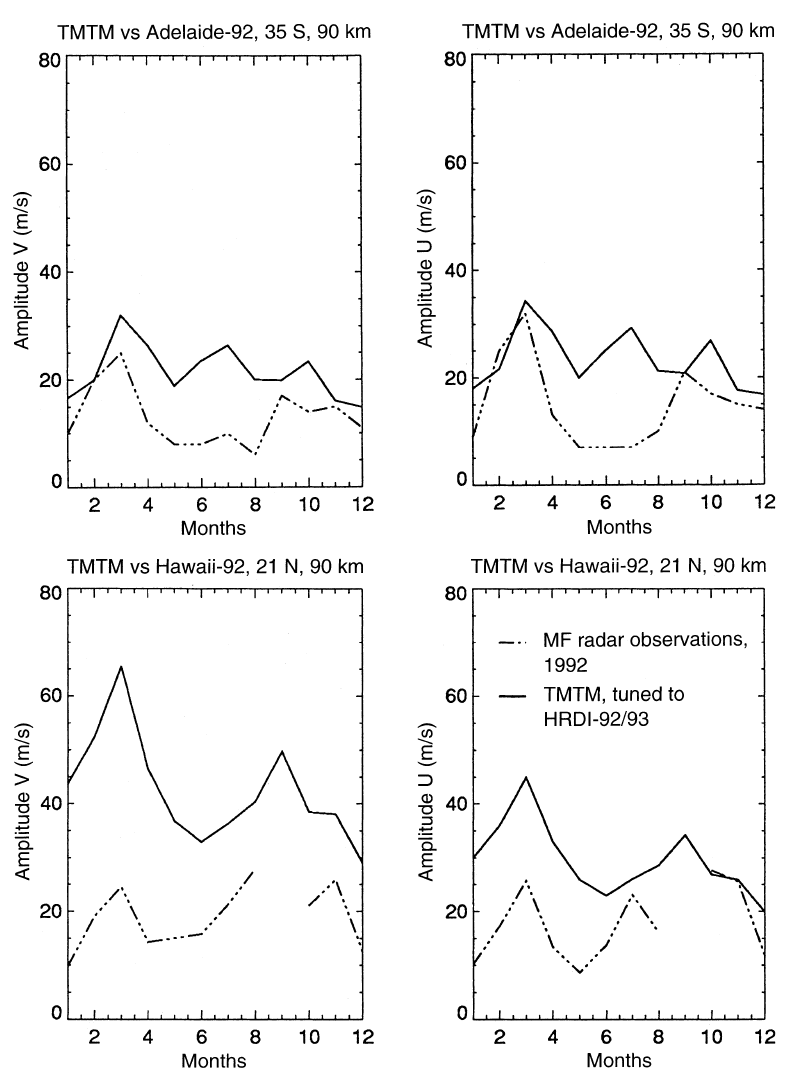
Fig. 9. Seasonal changes in the diurnal meridional and zonal winds predicted by TMTM and ob- served by the Adelaide MF radar (35 (cid:14) S) and Kauai (21 (cid:14) N) at 90 km. First column is amplitudes of meridional wind component. Second column is amplitudes of zonal wind component. Dash-dotted lines correspond to the 1992 monthly averaged MF radar diurnal tides. Solid lines are for the diurnal wind amplitudes predicted by